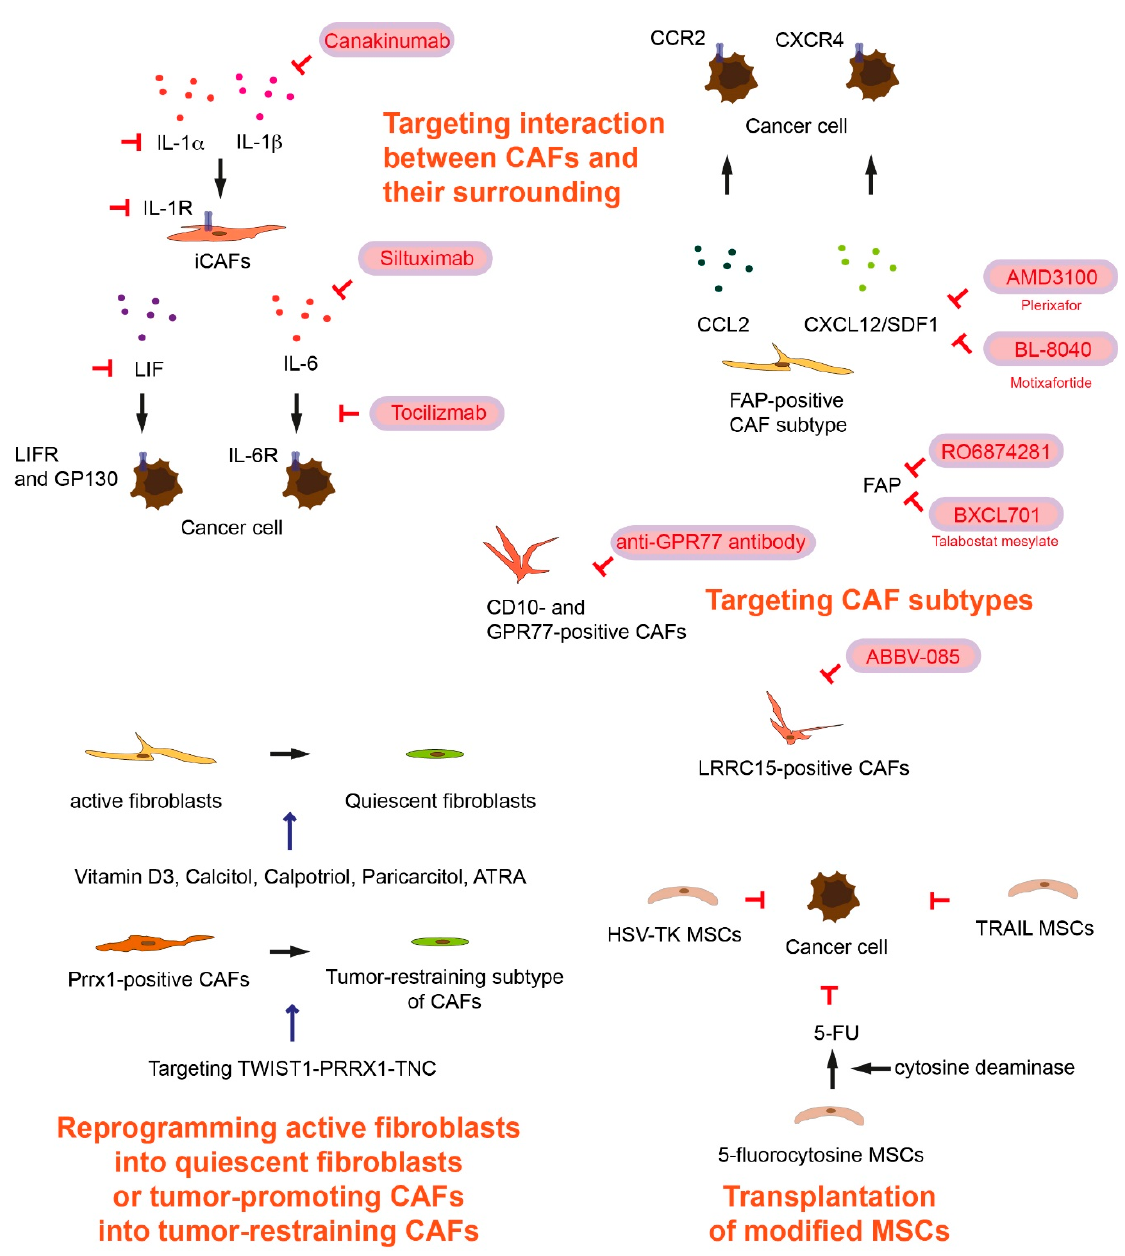
Figure 1. Therapeutic potential of targeting cancer-associated fibroblasts (CAFs), targeting interaction between CAFs and their surroundings, reprogramming active fibroblasts into quiescent fibroblasts or tumor promoting CAFs into tumor- restraining CAFs, and transplantation of modified mesenchymal stem cells (MSCs). The inhibition symbols are colored in red.